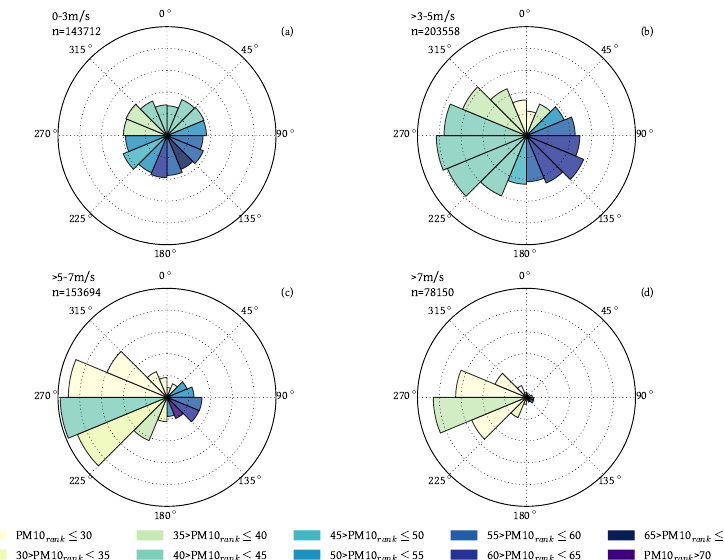
Figure 7. Relationship between PM10 rank , wind direction and wind speed. Setup of figures ( a – d ) is identical to previous plot. PM10 rank is generally higher when continental, i.e., easterly air masses dominate.